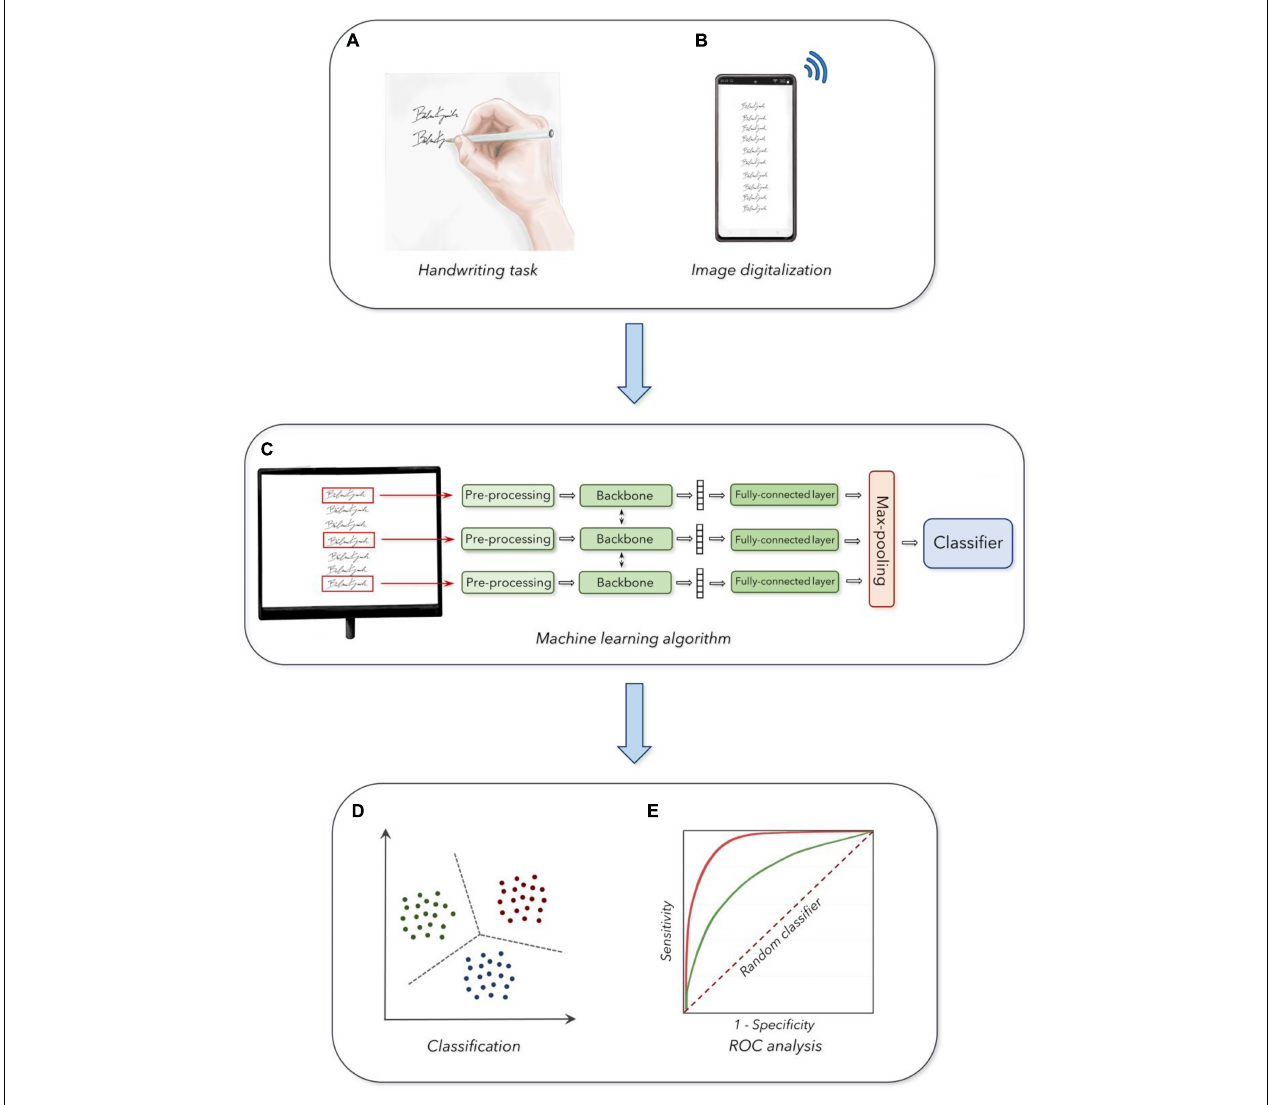
FIGURE 1 | Experimental design: (A) Acquisition of handwriting samples. (B) Digitalization and collection of the handwriting task. (C) Machine learning analysis of handwriting samples. (D) Output of the classifier in the three age groups. (E) Receiver operating characteristic curves (ROC analysis) for the discrimination between the three groups (see section “Materials and Methods” for further